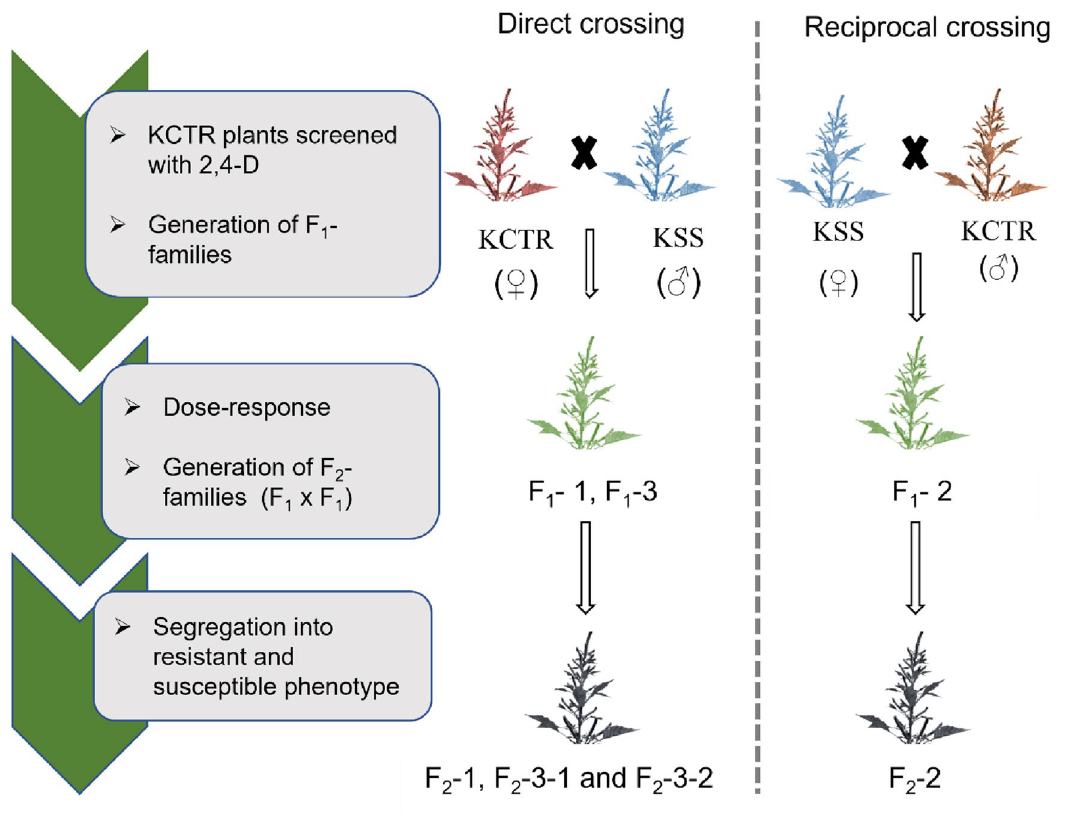
Figure 5. Schematic diagram showing the generation of F 1 and F 2 families of 2,4-D susceptible (KSS) and resistant (KCTR) Palmer amaranth and the experimental steps in the study (created with